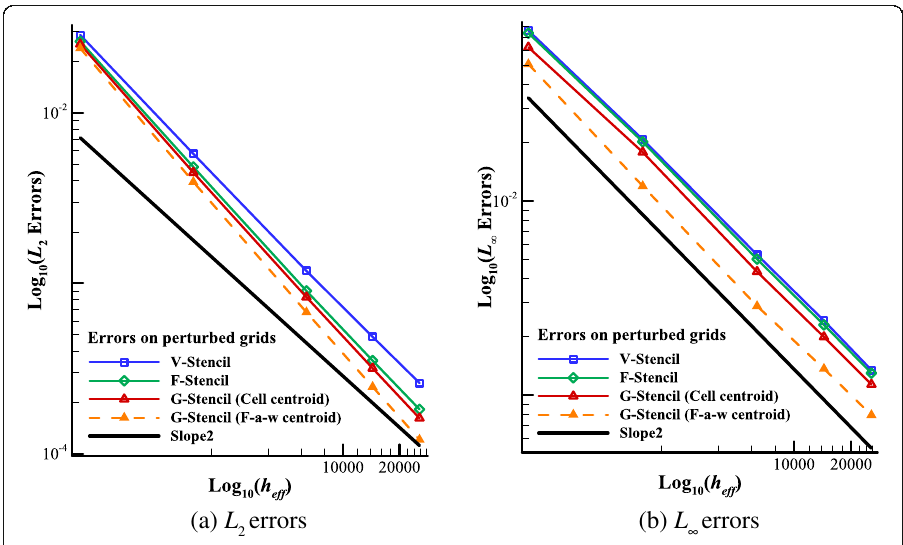
Fig. 22 ( a ) L 2 and ( b ) L ∞ errors. Errors of different stencils on randomly perturbed grids with AR ≈